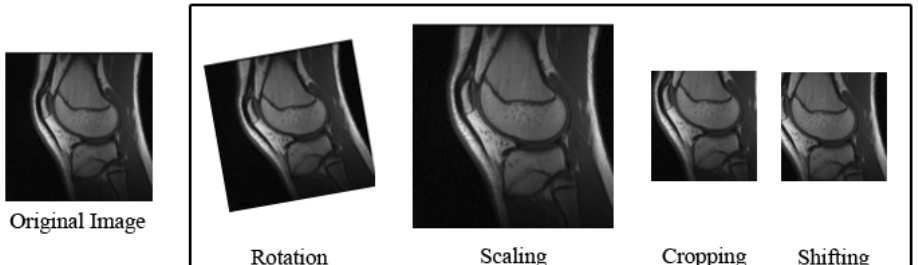
Figure 4. Examples of data augmentation operations applied in the proposed